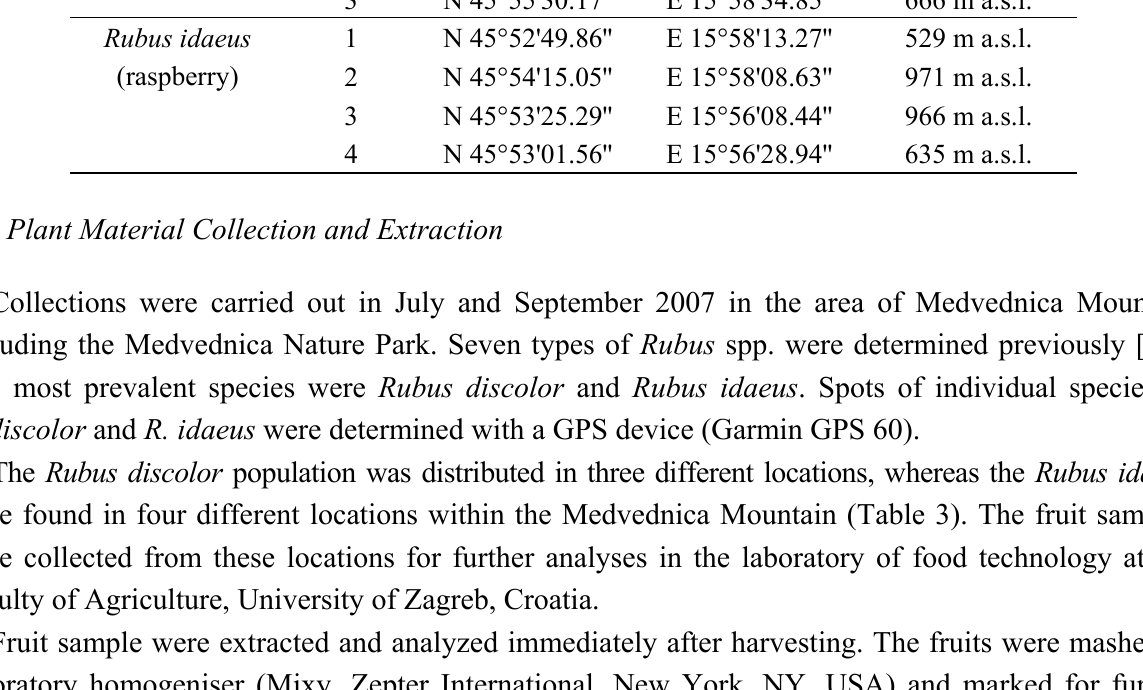
Table 3. Sampling location of the wild berries ( R. discolor and R. idaeus ) used in this study. Species Sample Longitude Latitude Altitude Rubus discolor (blackberry) Rubus